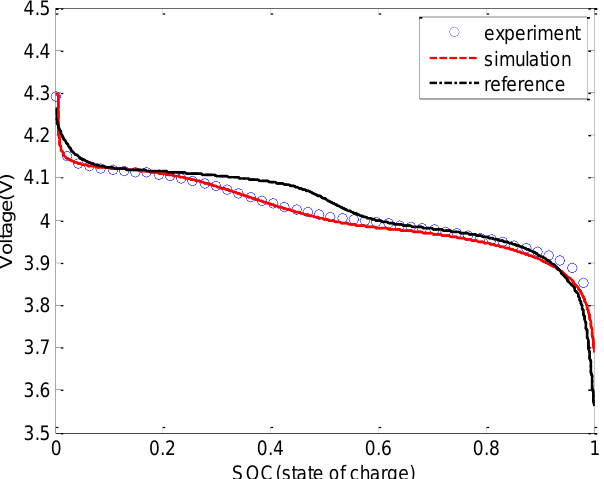
Figure 4. Open Circuit Voltage (OCV) profile comparing the experiment, simulation, and reference values [33].